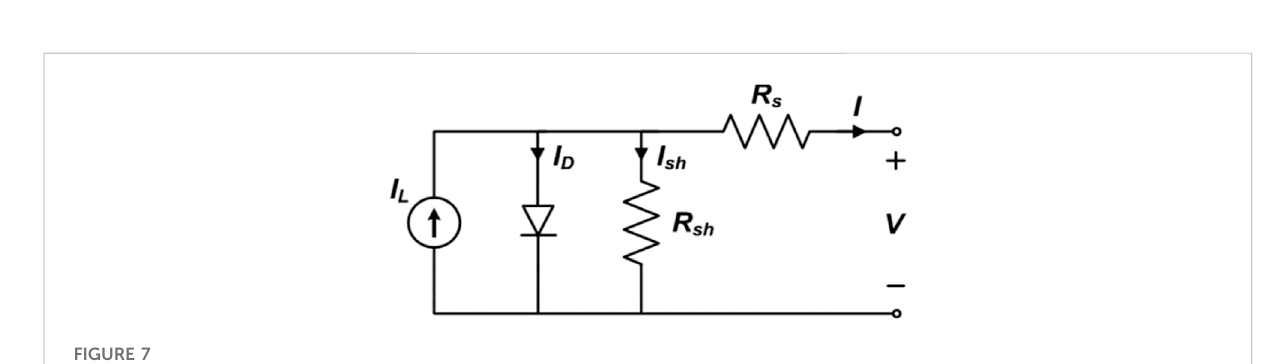
FIGURE 7 Equivalent circuit solar cell (Adhikari and Li,